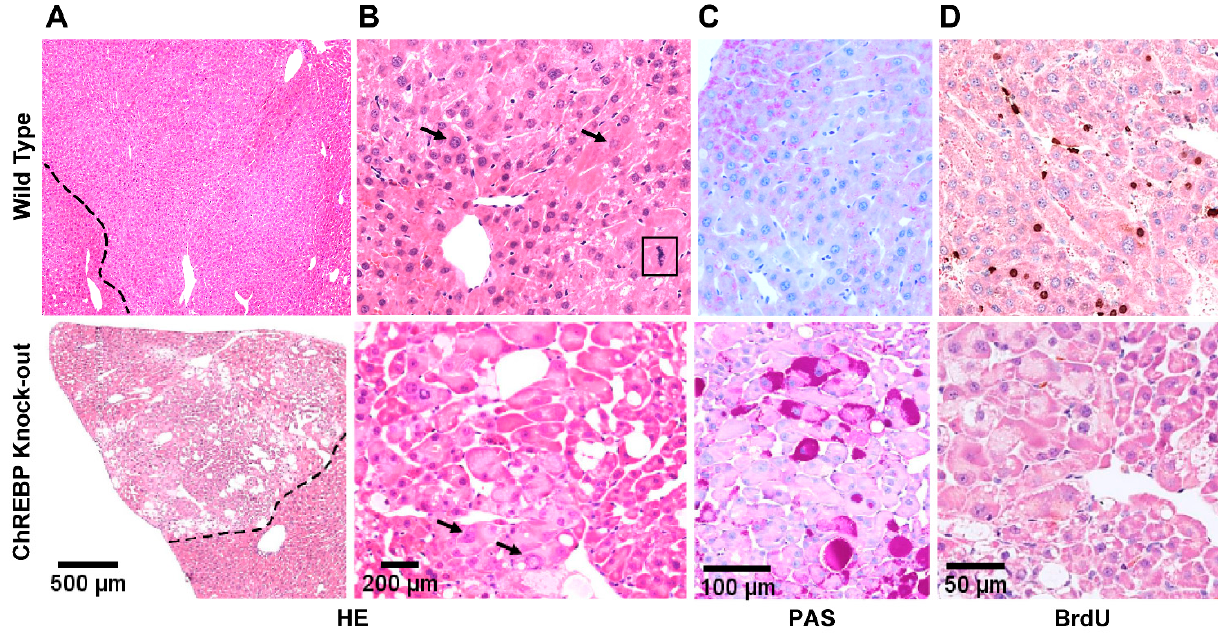
Figure 3. HCAs of WT and KO mice exhibit distinctive cell morphology. Representative histological and immunohistochemical images illustrate HCAs in a diabetic wild type (upper panel) and diabetic transplanted ChREBP-knockout mouse (lower panel). HCAs are featured with slightly enlarged nuclei of hepatocytes (indicated by arrows) in H&E staining ( A , B ), often less but partially in KO mice with increased glycogen storage in PAS reaction ( C , lower panel) and increased proliferative activity measured by staining of proliferation marker, BrdU ( D , lower panel) in KO mice. A clear demarcation (indicated by dotted lines) between adenomas and neighbouring extra focal liver tissues is illustrated ( A , B ). Square box depicts a mitotic figure ( B , upper panel). Length of the lower edge: ( A ) 2.5 mm, ( B ) 0.4 mm, ( C ) 0.35 mm, ( D ) 0.25 mm.